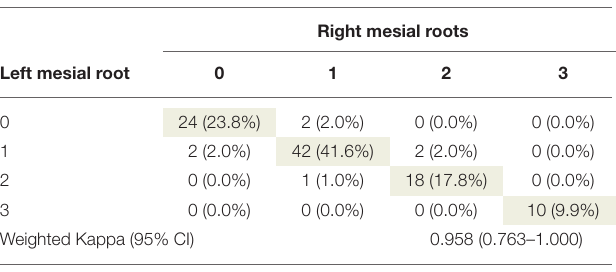
TABLE 5 | Agreement of apical position of left and right roots for each dog. (A) Agreement of apical position between left and right mesial roots for each